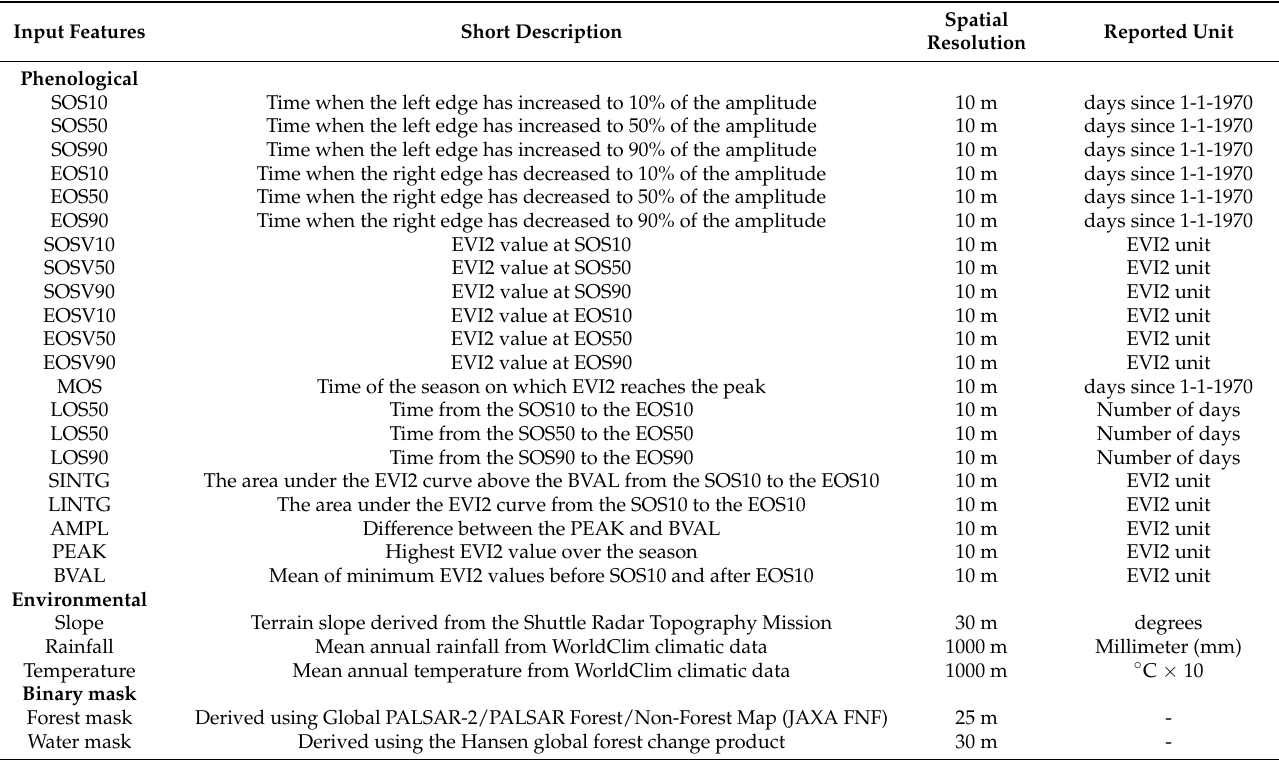
Table 1. Summary of input features used in this analyses to visually assess whether the resulting spatial patterns are smoother or whether there are any undesirable artifacts and patches, as well as comparing the resulted pheno- logical metrics with the MODIS Collection 6 MCD12Q2 phenology product. As described before, those data are currently the only operational global land cover dynamics products